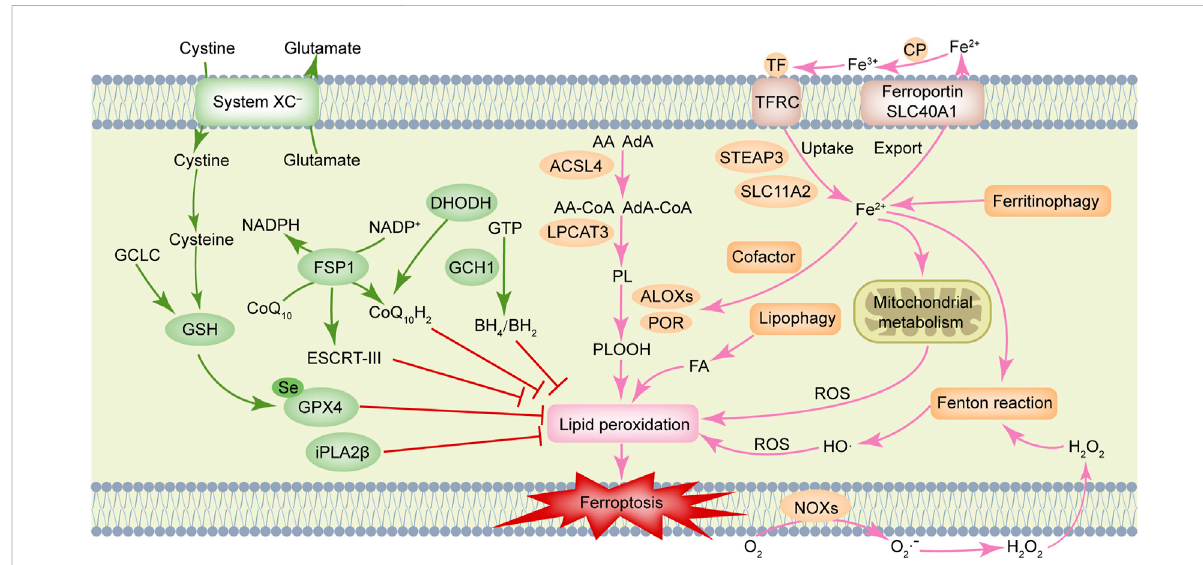
FIGURE 1 Molecular mechanisms of ferroptosis. Ferroptosis is driven by accumulation of polyunsaturated fatty acid-containing phospholipids (PUFA- PLs), transition metal iron and reactive oxygen species (ROS). Ferroptosis defense systems include cyst(e)ine/GSH/GPX4 axis, NAD(P)H/FSP1/CoQ 10 axis, DHODH/CoQ 10 axis, GCH1/BH 4 axis, and iPLA2 β , etc. AA, arachidonic acid; ACSL4, Acyl-coenzyme A synthetase long-chain family member 4; AdA, adrenic acid; ALOXs, arachidonate lipoxygenases; BH 2 , dihydrobiopterin; BH 4 , tetrahydrobiopterin; CoQ 10 , ubiquinone; CoQ 10 H 2 , ubiquinol; CP, ceruloplasmin; DHODH, dihydroorotate dehydrogenase; ESCRT-III, endosomal sorting complex required for transport-III; FA, fatty acid; FSP1, ferroptosis suppressor protein 1; GCH1, GTP cyclohydrolase 1; GCLC, glutamate-cysteine ligase catalytic subunit; GPX4, glutathione